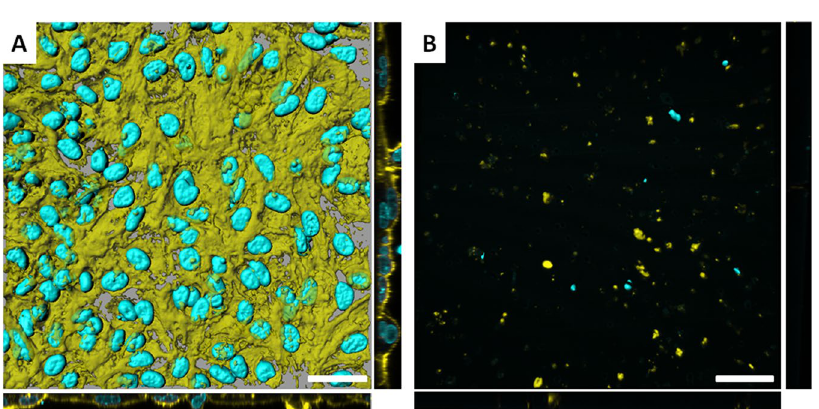
Figure 2. Surface rendered confocal laser scanning microscopy (LSM) images of ( A ) the triple cell co-culture model cultured on a micro-porous membrane insert, and ( B ) a micro-porous membrane insert that originally had the co-culture system cultured upon it and subsequently having been treated with Trypsin-EDTA for ≥ 10 minutes at 37 °C, 5% CO 2 . Image ( B ) indicates that the Trypsin-EDTA was successful in detaching the majority of the co-culture from the micro-porous membrane insert in order to form a multi-cell suspension. Image A shows the morphology of the co-culture system when grown under normal culture conditions. Both images show staining for the F-actin cytoskeleton (Phalloidin-Rhodamine) and nuclear (DAPI) regions respectively. Scale bars represent 30 µ m. In both ( A and B ), images show the XY plane in a 3D rendered format (as computed using the software IMARIS ® , Switzerland), as well as planar views of XZ and YZ shown in